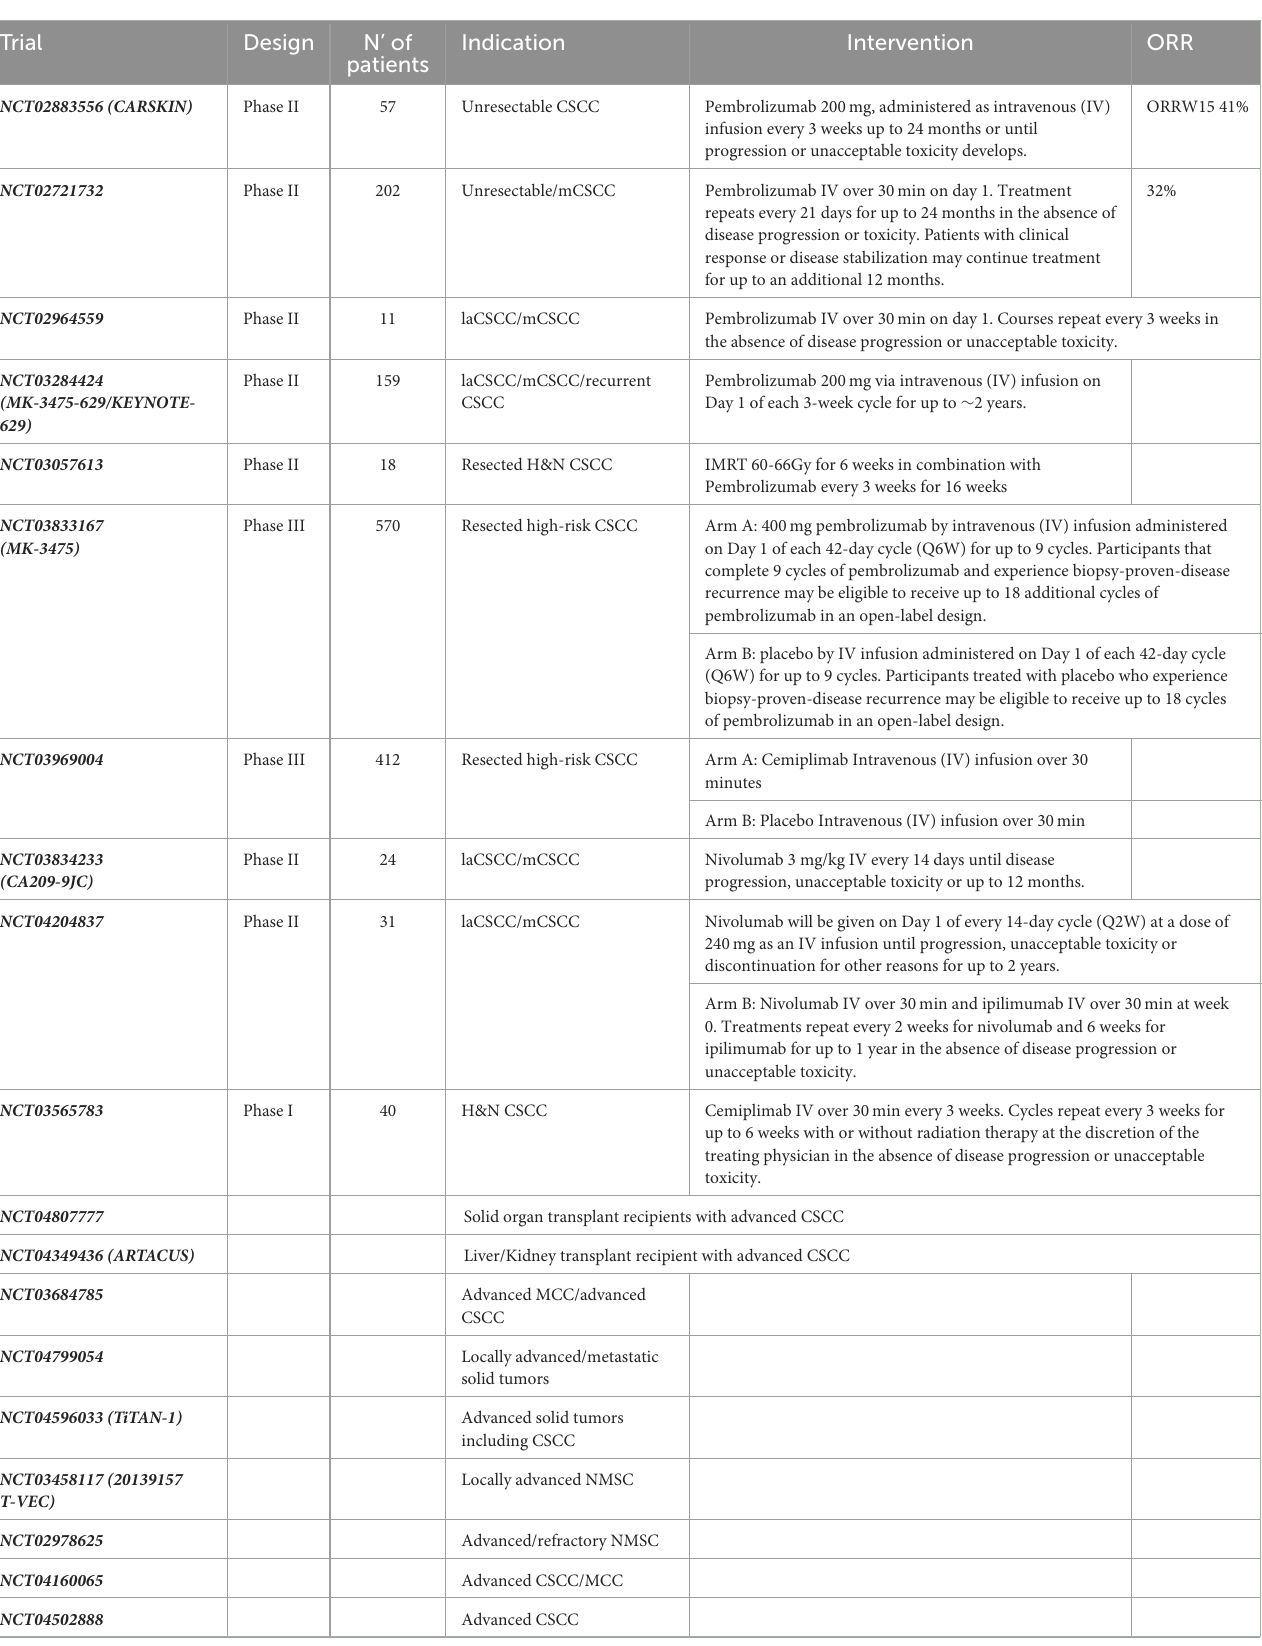
TABLE 3 Ongoing trials in CSSC. Trial Design N’ of Indication Intervention ORR patients Phase II 57 Unresectable CSCC ORRW15